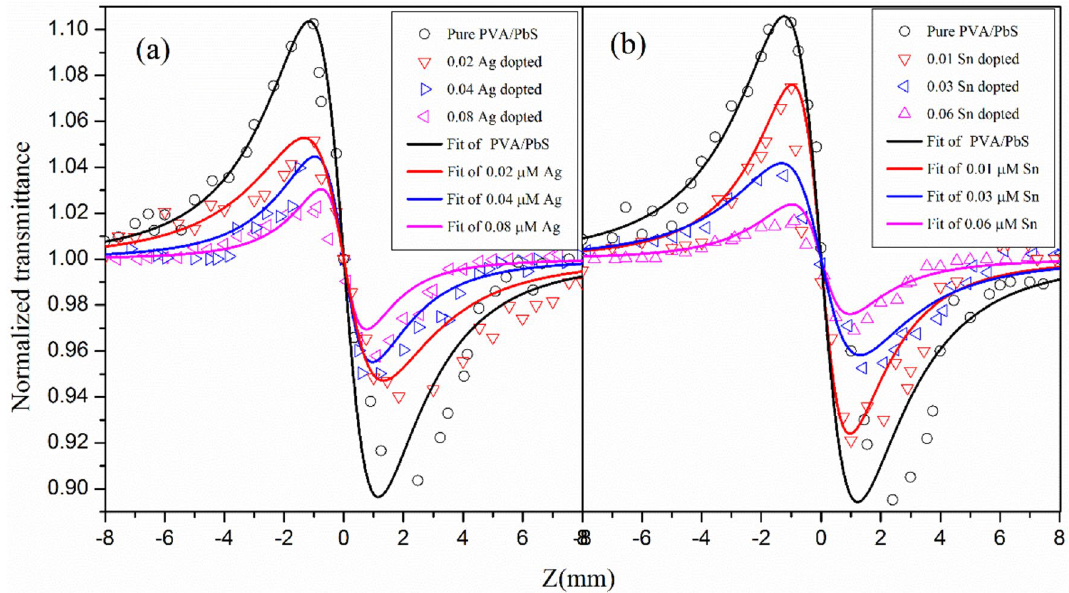
Figure 8. Z-scan open aperture results for ( a ) undoped and Ag-doped, and ( b ) undoped and Sn-doped, PbS/ PVA nanocomposites samples with different doping concentrations. Sample − n 2 × 10 −9 (m/W) PbS/PVA 0.55